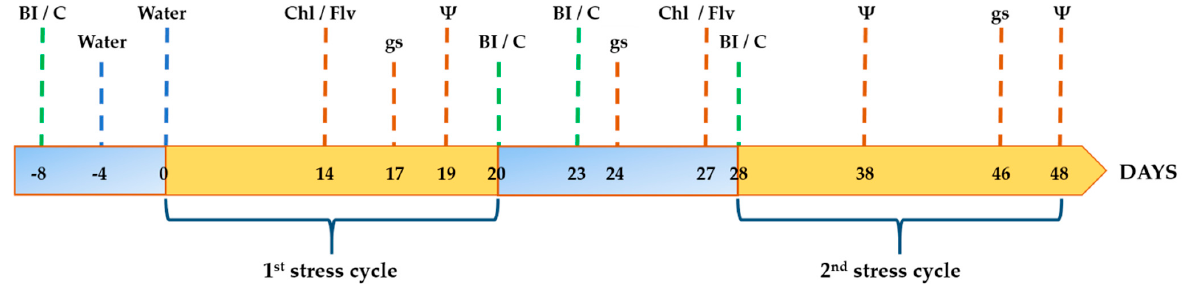
Figure 2. Schedule of activities performed during a drought stress experiment. The timing for bacterial inoculation (BI), or 10 mM MgSO 4 · 7H 2 O amendment in the case of control (C) plants, is shown by green discontinuous lines. Water doses are shown by blue discontinuous lines. The different physiological/biochemical parameters evaluated are shown with discontinuous brown lines. Plants were subjected to two (20-days long each) drought cycles (1st and 2nd stress cycles; orange segments). Chl, chlorophyll; Flv, flavonoids; gs, stomatal conductance; Ψ , stem water potential. This experiment was performed twice.